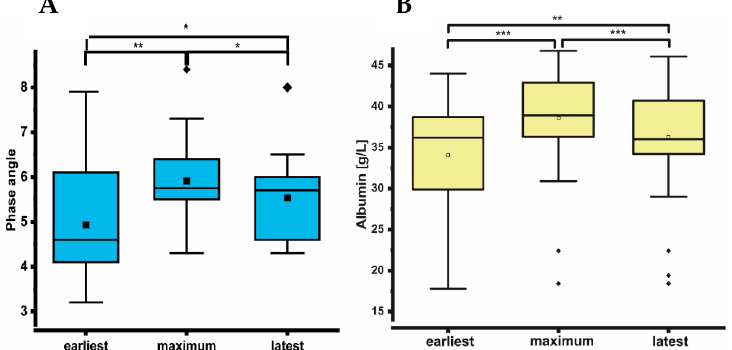
Figure A1. ( A ) Body impedance analysis (BIA) data were available from 22 of 50 patients. Phase angle was compared at the earliest, the maximum and the latest time point (similar to FIRST, MAX, and LAST). Phase angle significantly increased between the earliest and maximum time point and decreased slightly but significantly thereafter (Friedman’s test and Wilcoxon test). ( B ): Serum albumin values were available from 46 of 50 patients and were compared at the earliest, the maximum and the latest time point (similar to FIRST, MAX, and LAST). Serum albumin values significantly increased between the earliest and maximal time point and decreased slightly but significantly thereafter (Friedman’s test and Wilcoxon test). Together the data indicate that modification of PS did not result in overhydration ( ▫ mean; ◊ statistical outlier;* p < 0.05; ** p < 0.01; *** p < 0.001).